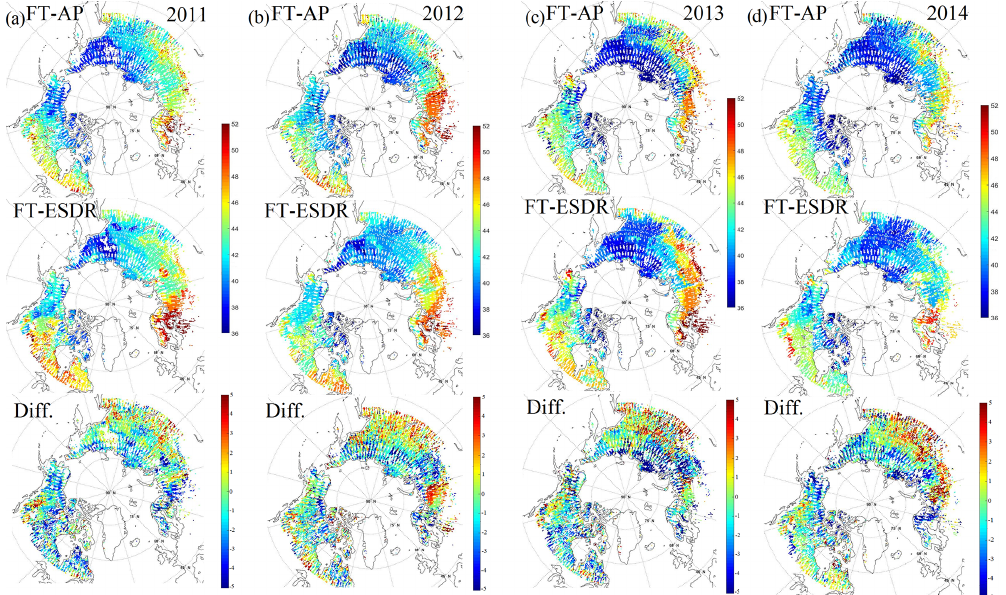
Figure 4. Freeze onset maps, where colors indicate the week of year, for (a) 2011, (b) 2012, (c) 2013 and (d) 2014 with FT-AP (top), FT-ESDR (middle) and difference between the products (Diff. = FT-AP minus FT-ESDR;